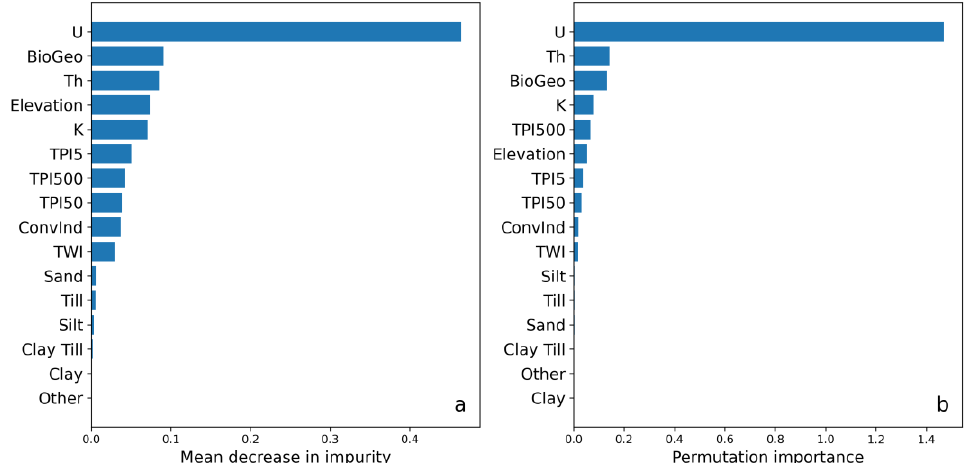
Figure 4. ( a ) Covariate importance based on mean decrease in impurity and ( b ) permutation importance of the digital soil mapping (DSM) model. The covariates (see Table 2) were taken from airborne gamma-ray data (U, Th, and K), a digital elevation model (TPI5, TPI50, and TPI500 = topographic position index with 5, 50, and 500 ha radius, respectively; ConvInd = convergence index; TWI = topographic wetness index), biogeochemical data (BioGeo = cokriged with zinc), and qua- ternary soil deposit classes (sand, till, silt, till clay, clay, and other). Higher values indicate higher covariate